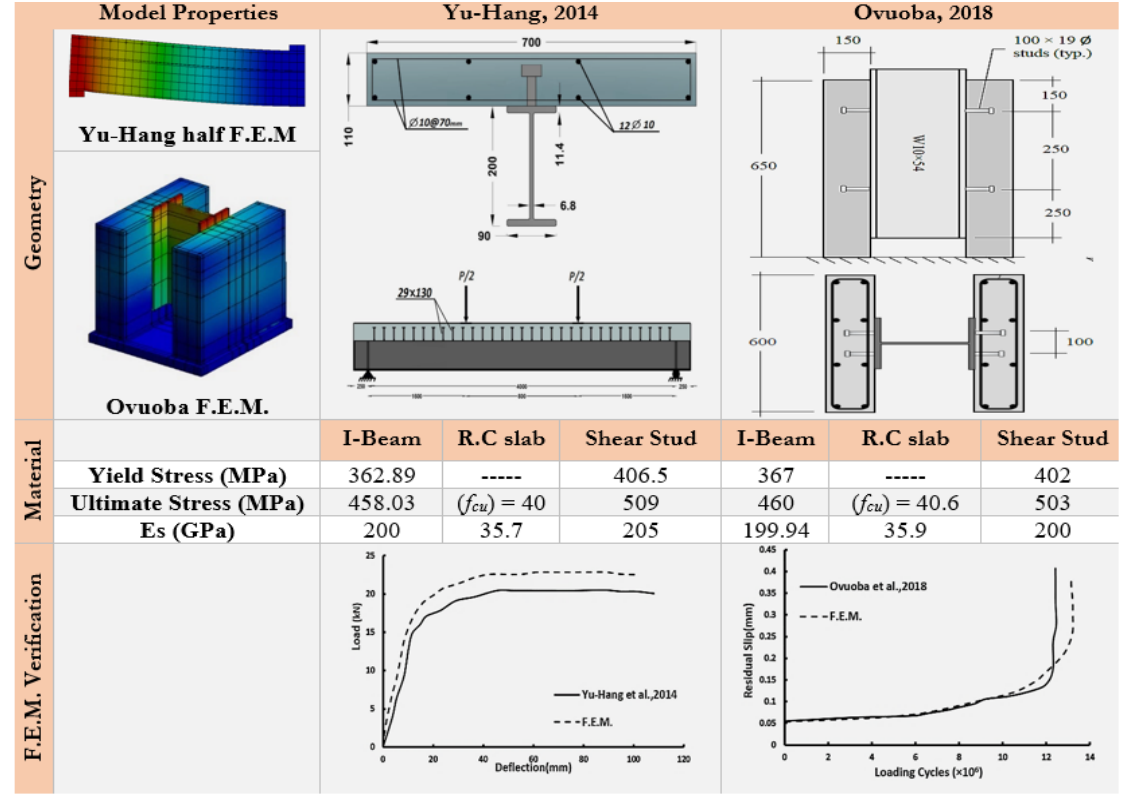
Figure 3: Details of validated